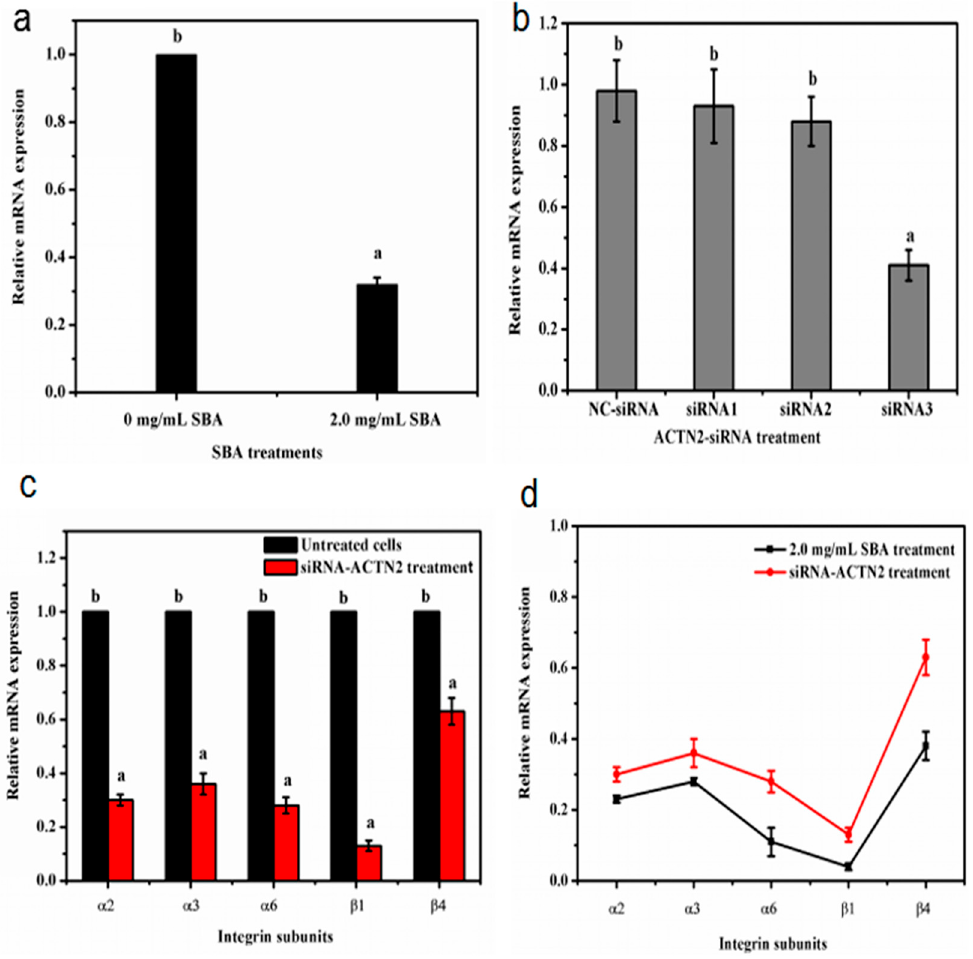
Figure 8. ( a – d ) The relationship between SBA, integrins and ACTN2. ( a ) Effects of SBA on mRNA expression of ACTN2 in IPEC-J2. The cells were treated with 0 or 2.0 mg/mL SBA for 24 h, mRNA levels of ACTN2 were analyzed by qRT-PCR; ( b ) Gene silencing efficiency of siRNA- ACTN2 in IPEC-J2. After transfection with different pairs Negative control (NC)-siRNA, siRNA1, siRNA2, siRNA3) of siRNA- ACTN2 sequences for 48 h, mRNA expression levels of ACTN2 in different siRNA treatments were assessed using qRT-PCR; ( c ) The relative mRNA levels of integrin α 2, α 3, α 6, β 1 and β 4 in siRNA- ACTN2 treatment. The cells were treated with control or ACTN2 -siRNA3 for 24 h and mRNA expression of integrins were detected using qRT-PCR; ( d ) The gene expression trends of different integrins ( α 2, α 3, α 6, β 1 and β 4) in SBA and siRNA- ACTN2 treatments. Means with different superscripts are significantly different in compare with its control. All values are presented as means ± SEM ( n = 3).